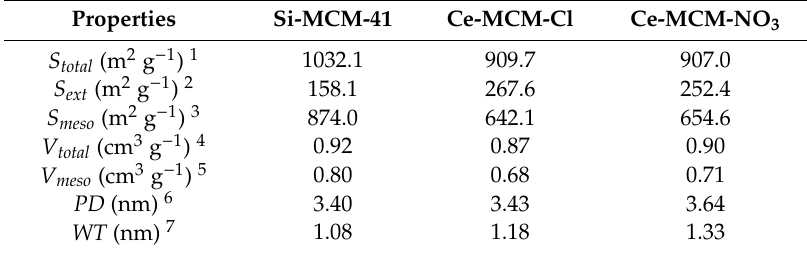
Table 4. Textural properties for the calcined MCM-41 materials.